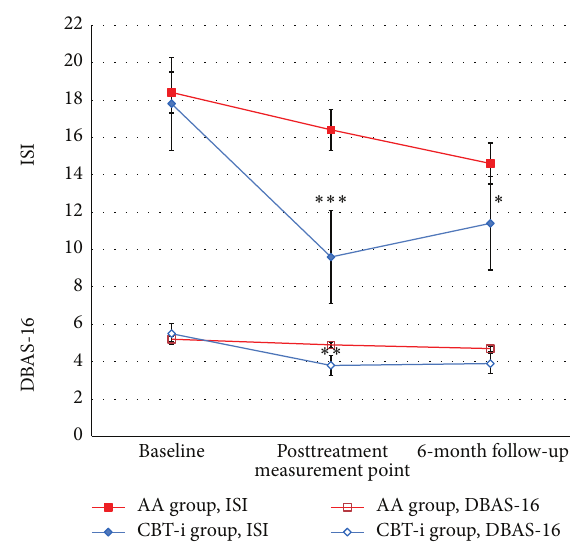
Figure 3: Changes in ISI and DBAS-16 scores between groups from baseline to posttreatment measurement point and from baseline to 6-month follow-up. ∗ 𝑝 < 0.05 , ∗∗ 𝑝 < 0.01 , and ∗∗∗ 𝑝 < 0.001 . ISI: Insomnia Severity Index; DBAS-16: Dysfunctional Beliefs and Attitudes about Sleep